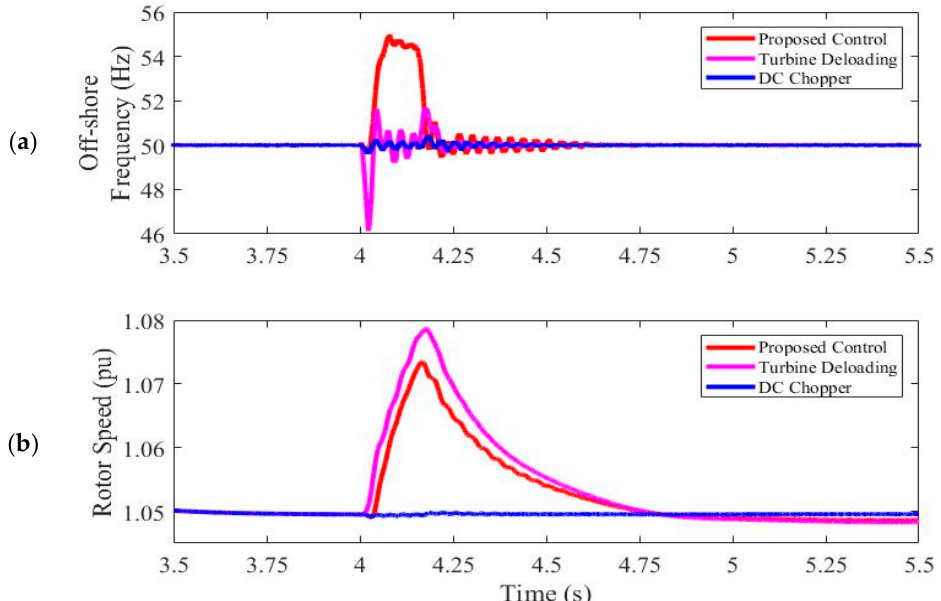
Figure 8. Simulation results of the on-shore fault scenario with a 0.001 Ω fault resistance . ( a ) Off-shore frequency for each simulation case. ( b ) DFIG rotor turbine acceleration for each simulation case.